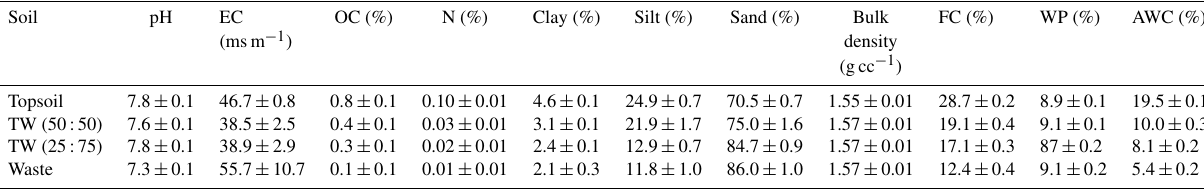
Table 2. Soil physicochemical and hydraulic properties of growth media types (mean ± SE, n = 3). EC: electrical conductivity, OC: or- ganic C; N: total N, FC: field capacity, WP: wilting point, AWC: available water content (difference between FC and WP). Soil pH